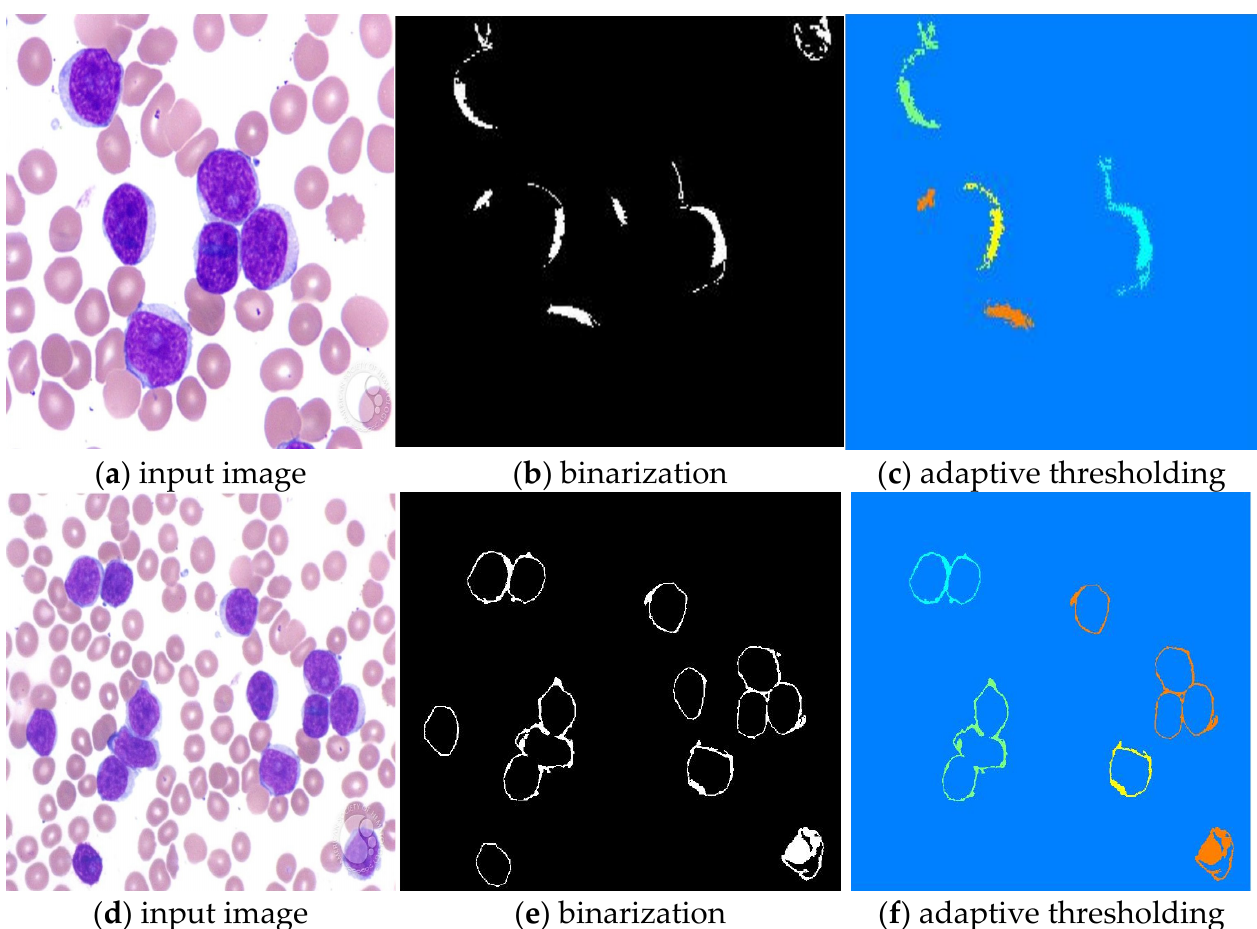
Figure 8. Isolating cytoplasm from H&E-Stained image.